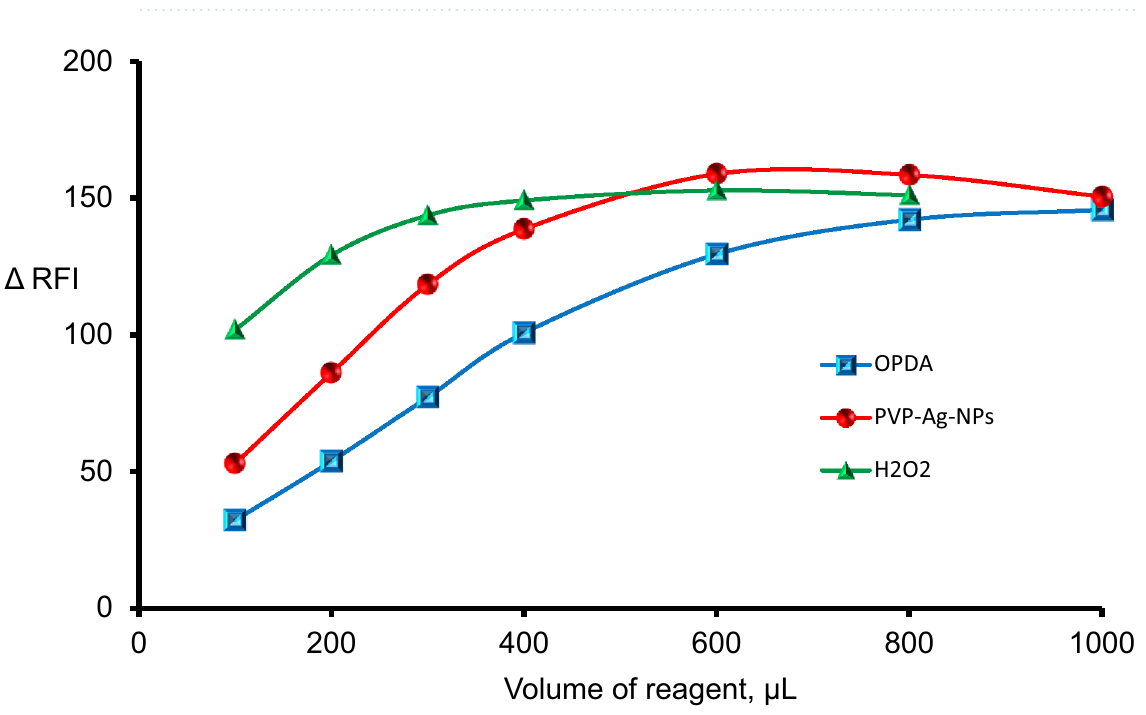
Figure 4. Investigating the volume of reagents for Hg 2+ (1.0 µM) detection by the suggested method.